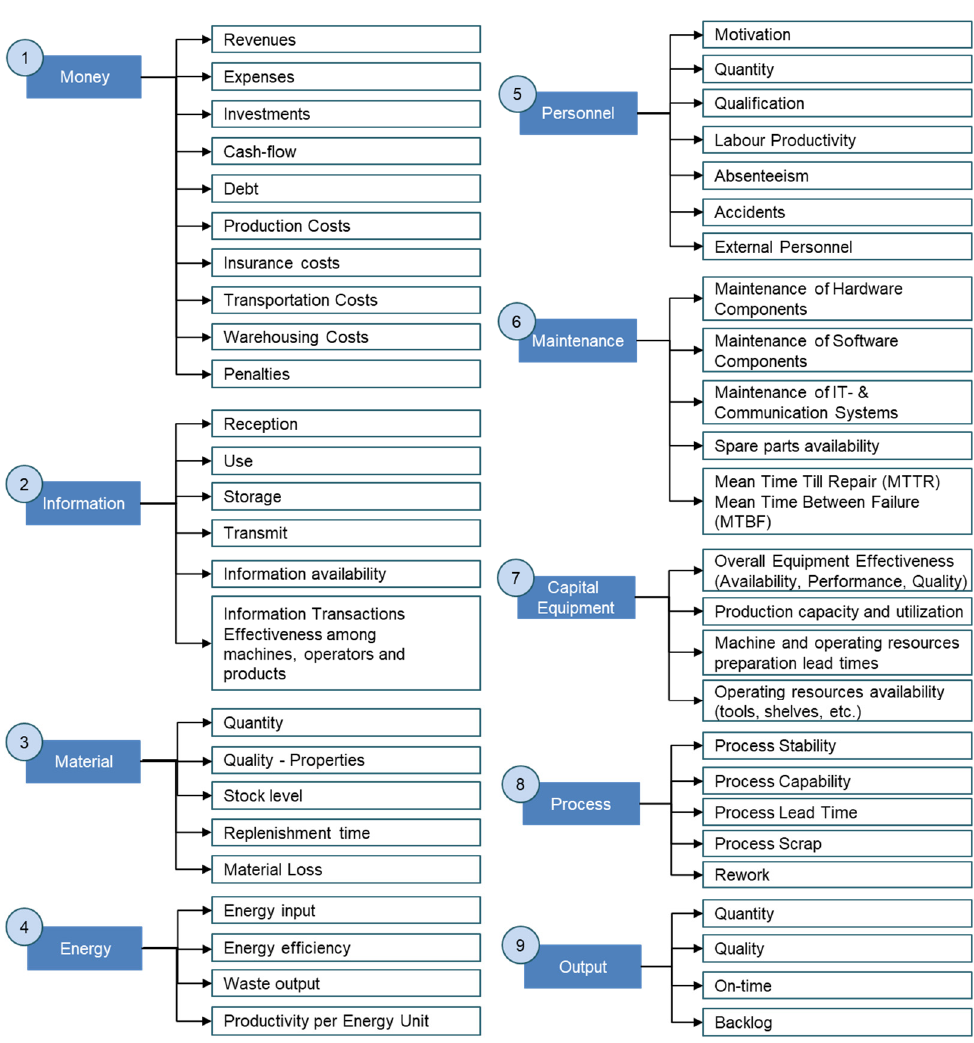
Figure 2. Manufacturing process factors and parameters (own